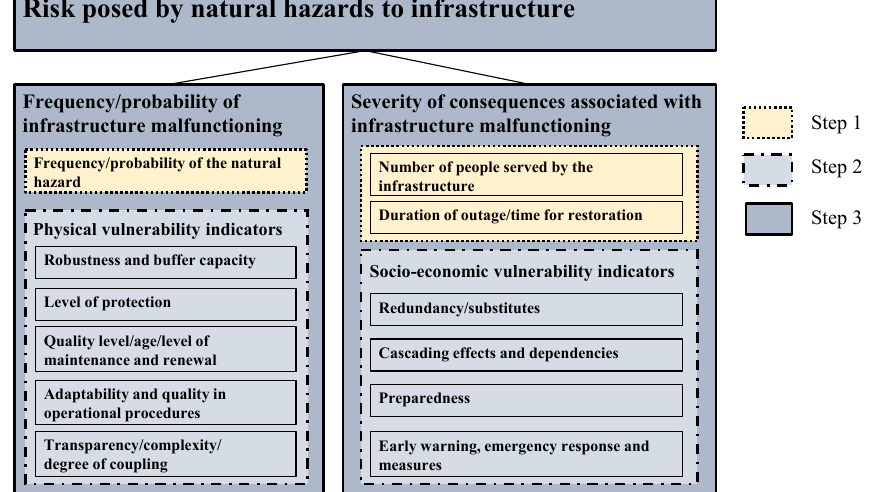
Figure 2. Illustration of the method for semi-quantitative analyses. The indicators with dotted frames are assessed quantitatively for an initial categorisation of the probability and consequence (Step 1). The physical and socio-economic vulnerability indicators (dash–dot frames) are assessed semi-quantitatively (Step 2). The information from the first two steps is aggregated in the third step to assess the probability of infrastructure malfunctioning and the severity of the consequences.